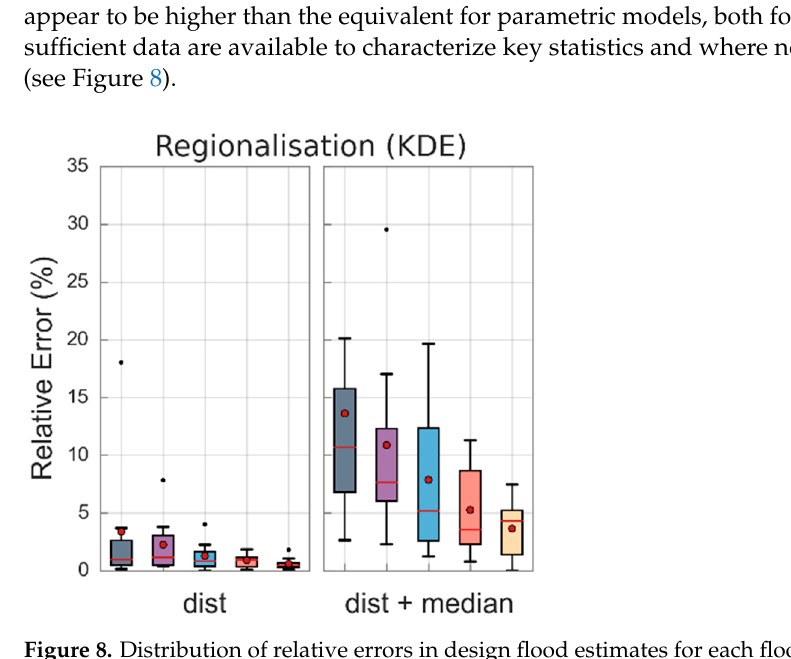
Figure 8. Distribution of relative errors in design flood estimates for each flood quantile across the eight study catchments using various methods to regionalize probability-distributed initial losses (nonparametric model).